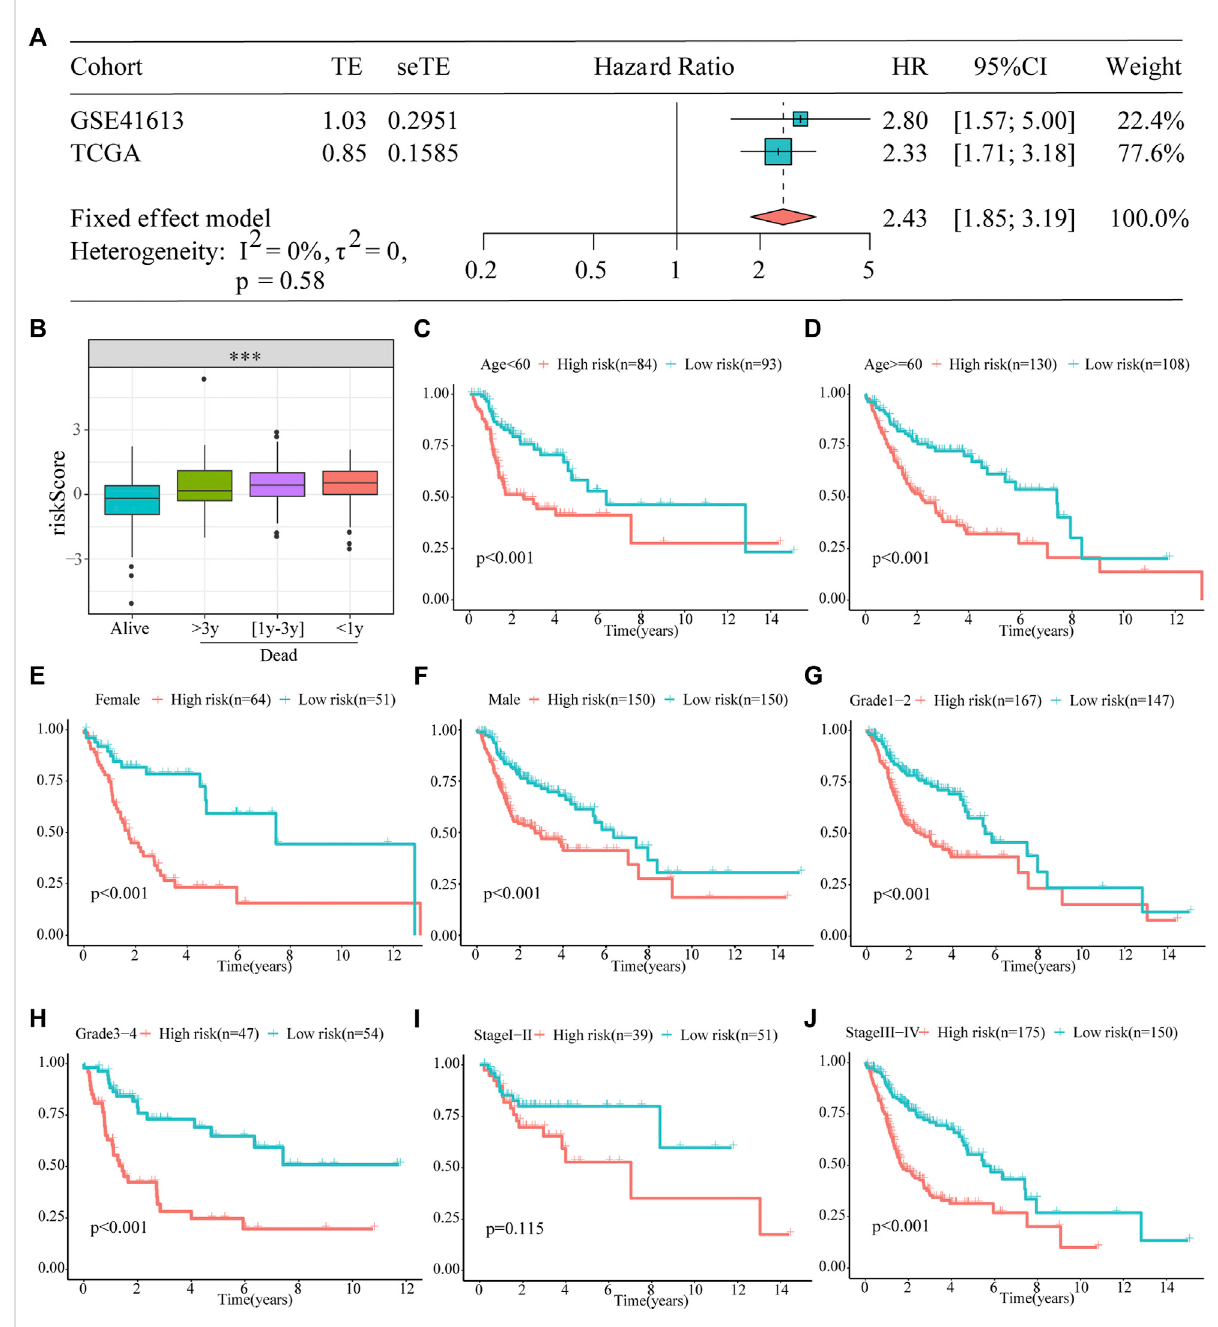
FIGURE 4 Prognostic signature can be used as a marker of survival in pooled cohorts and subgroups. (A) Meta-analysis. (B) The risk score is higher for patients who died than for those who were alive, particularly in the group with shorter survival. (C – J) Kaplan – Meier survival analysis of the signature between the high- and low-risk groups in TCGA cohort strati fi ed by different clinicopathological